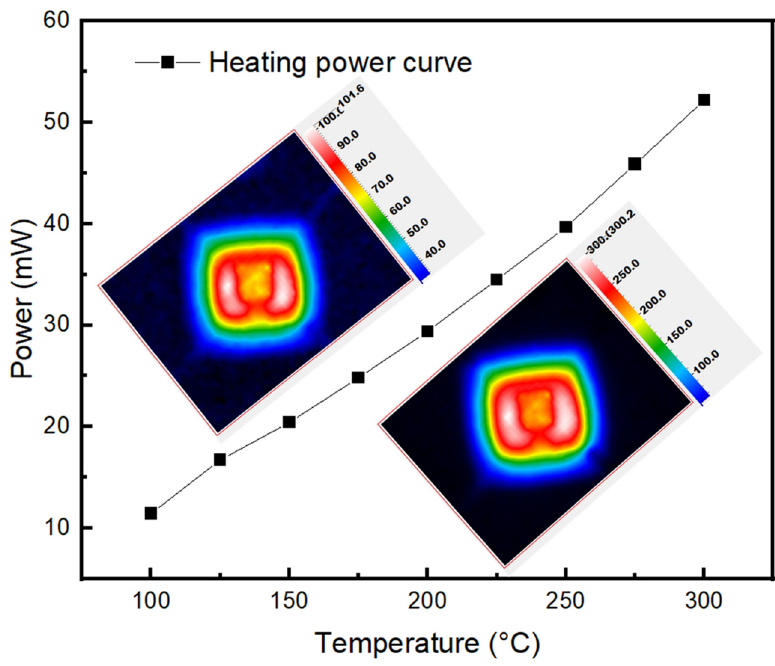
Figure 8. Power vs. Temperature graph of the MEMS microheater.